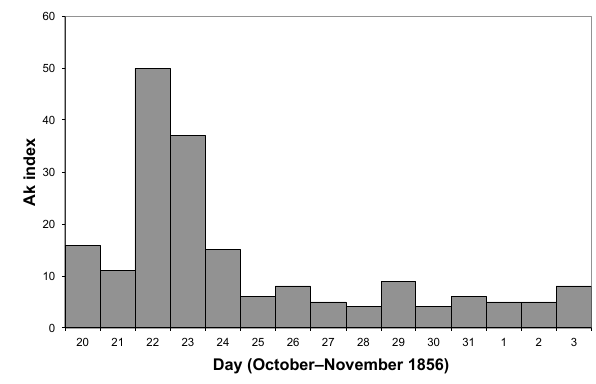
Figure 2. Daily ak index (Nevanlinna, 1997) during the period 20